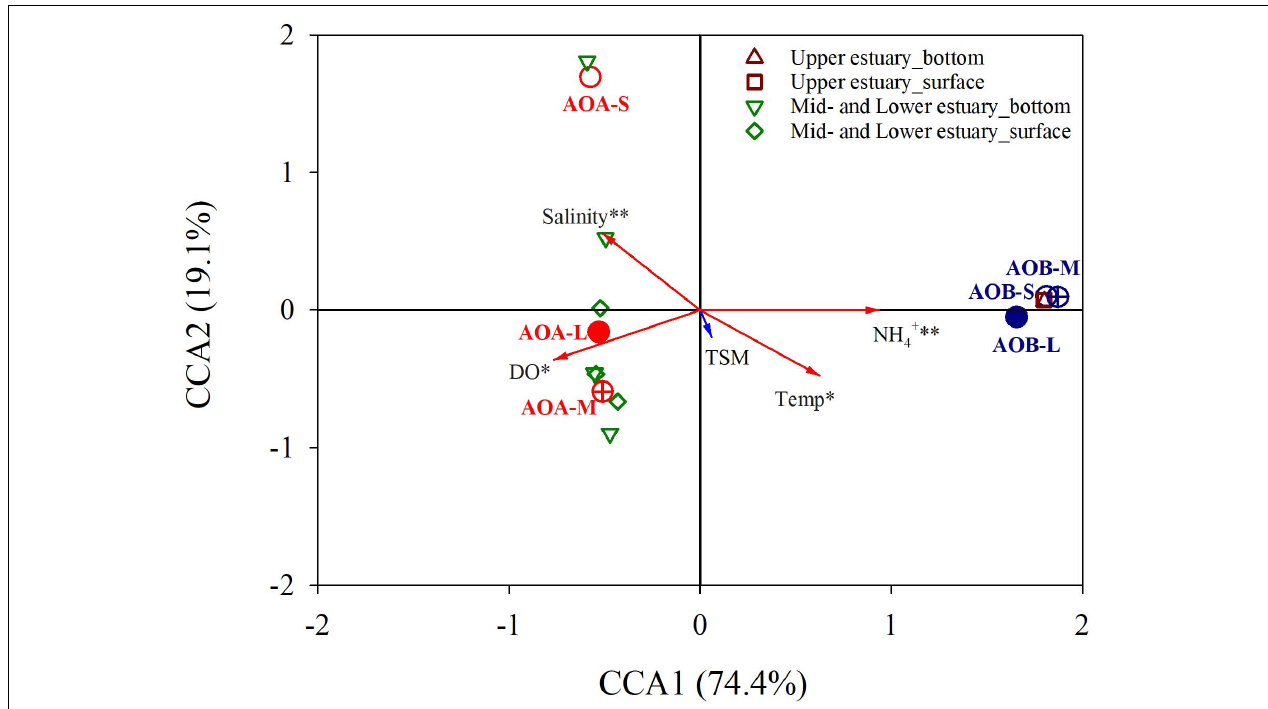
FIGURE 5 | Constrained ordinations of the DNA-based AOB and AOA amo A genes on the large (L; > 3.0 µ m; solid circle), medium (M; 0.45–3.0 µ m; crossed circle), and small (S; 0.22–0.45 µ m; open circle) size-fractionated particles with environmental factors by canonical correspondence analysis (CCA). Samples in the surface and bottom waters from the upper estuary ( n = 2) and the Lingdingyang (the mid- and lower estuary, n = 7) are also shown. The vectors represent the environmental variables. These variables that have statistically significant influence on the distribution of size-fractionated ammonia oxidizers are marked with asterisk and revealed by the red arrows. Temp stands for